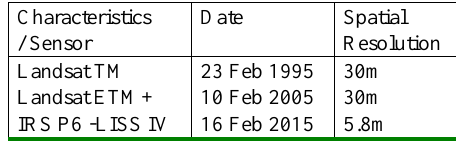
Table 1. Satellite images used in this study